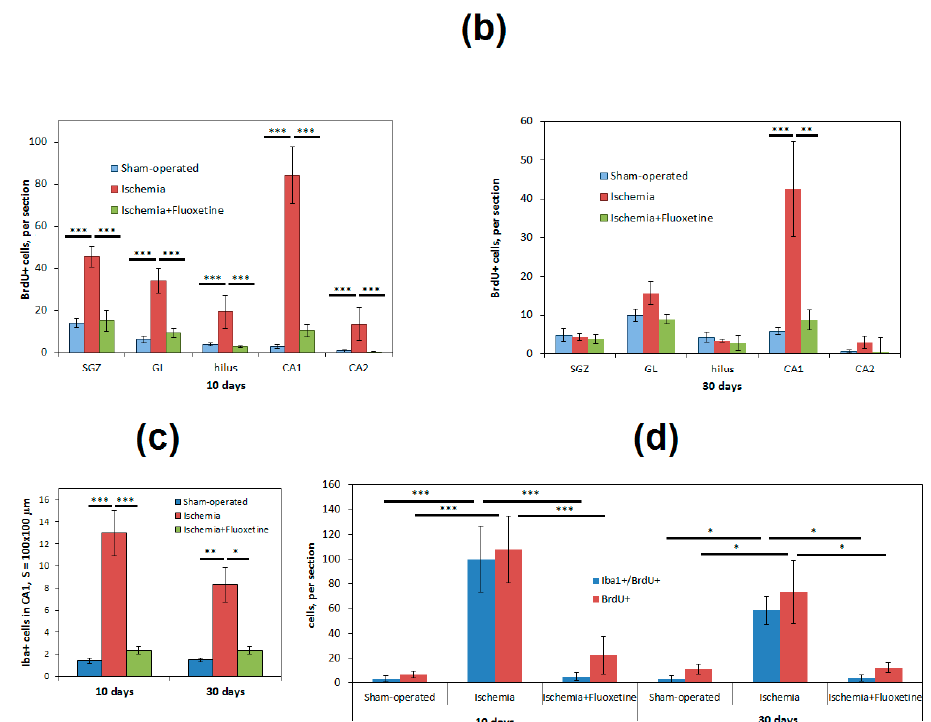
Figure 2. Fluoxetine effect on cell proliferation and inflammation. ( a ) Micrographs of the CA1 field of the hippocampus of the sham-operated animals, positive controls, and fluoxetine-treated animals at day 11 after GCI. Brain sections were stained with BrdU, NeuN and DAPI (top row) and BrdU, Iba1 and DAPI, 63 × magnification; ( b ) Comparison of BrdU+ cells in hippocampal regions between the groups at days 11 ( b , left) and 31 ( b , right) after surgery; ( c ) Comparison of Iba1+ cells in the CA1 field between the groups at days 11 and 31 after surgery; ( d ) The number of Iba1 \ BrdU double-positive cells in the CA1 field at days 11 and 31 after surgery compared to the total number of BrdU+ cells. Significant differences between the groups, according to ANOVA after Bonferroni’s correction for multiple comparisons: * p < 0.05, ** p < 0.01, *** p < 0.001.